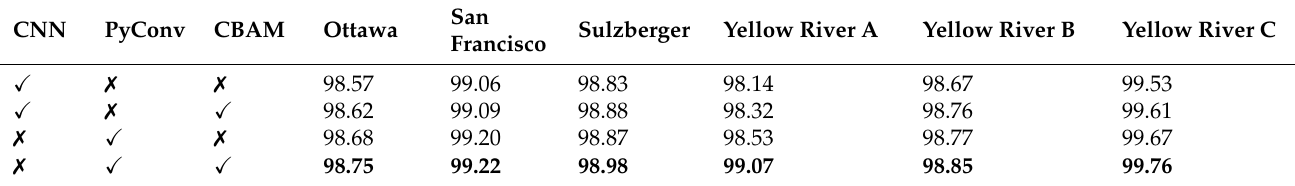
Table 10. PCC value [%] of the six datasets in ablation study of the proposed PCBA-Net.